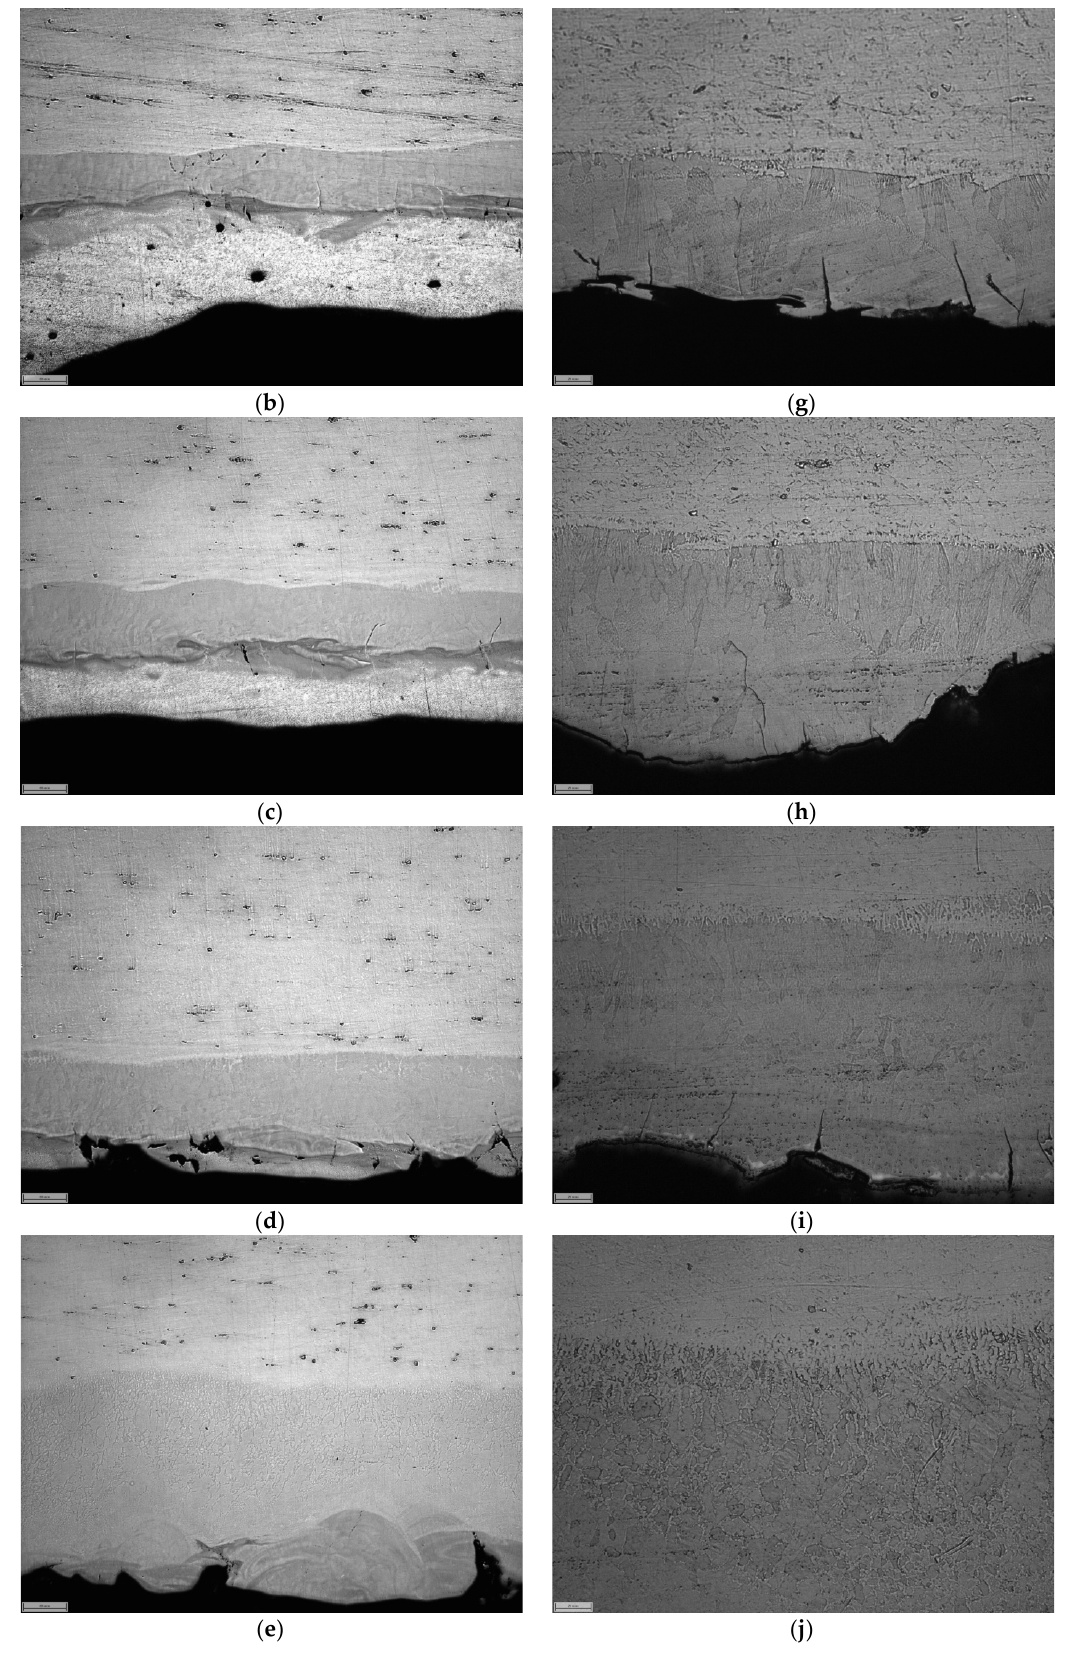
Figure 4. Microstructure of bimetal interface zone: ( a , f ) SLM scanning mode 1; ( b , g ) SLM scanning mode 2; ( c , h ) SLM scanning mode 3; ( d , i ) SLM scanning mode 4; ( e , j ) SLM scanning mode 5; ( a – e ) 200 × , without etching; ( f – j ) 500 × , after